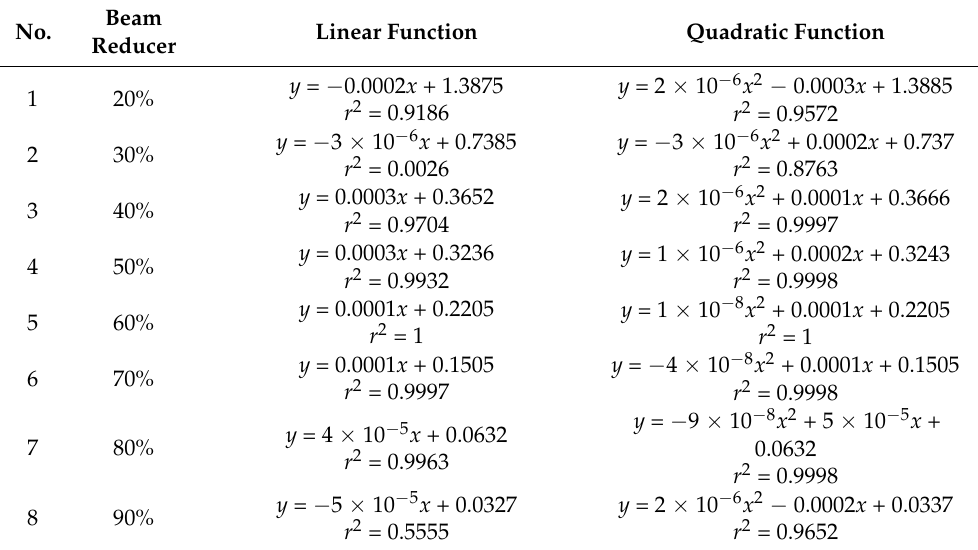
Table 5. Calibration functions presenting the relationship between NH 3 concentrations and NDIR analyzer signals with respect to various inner diameters of beam